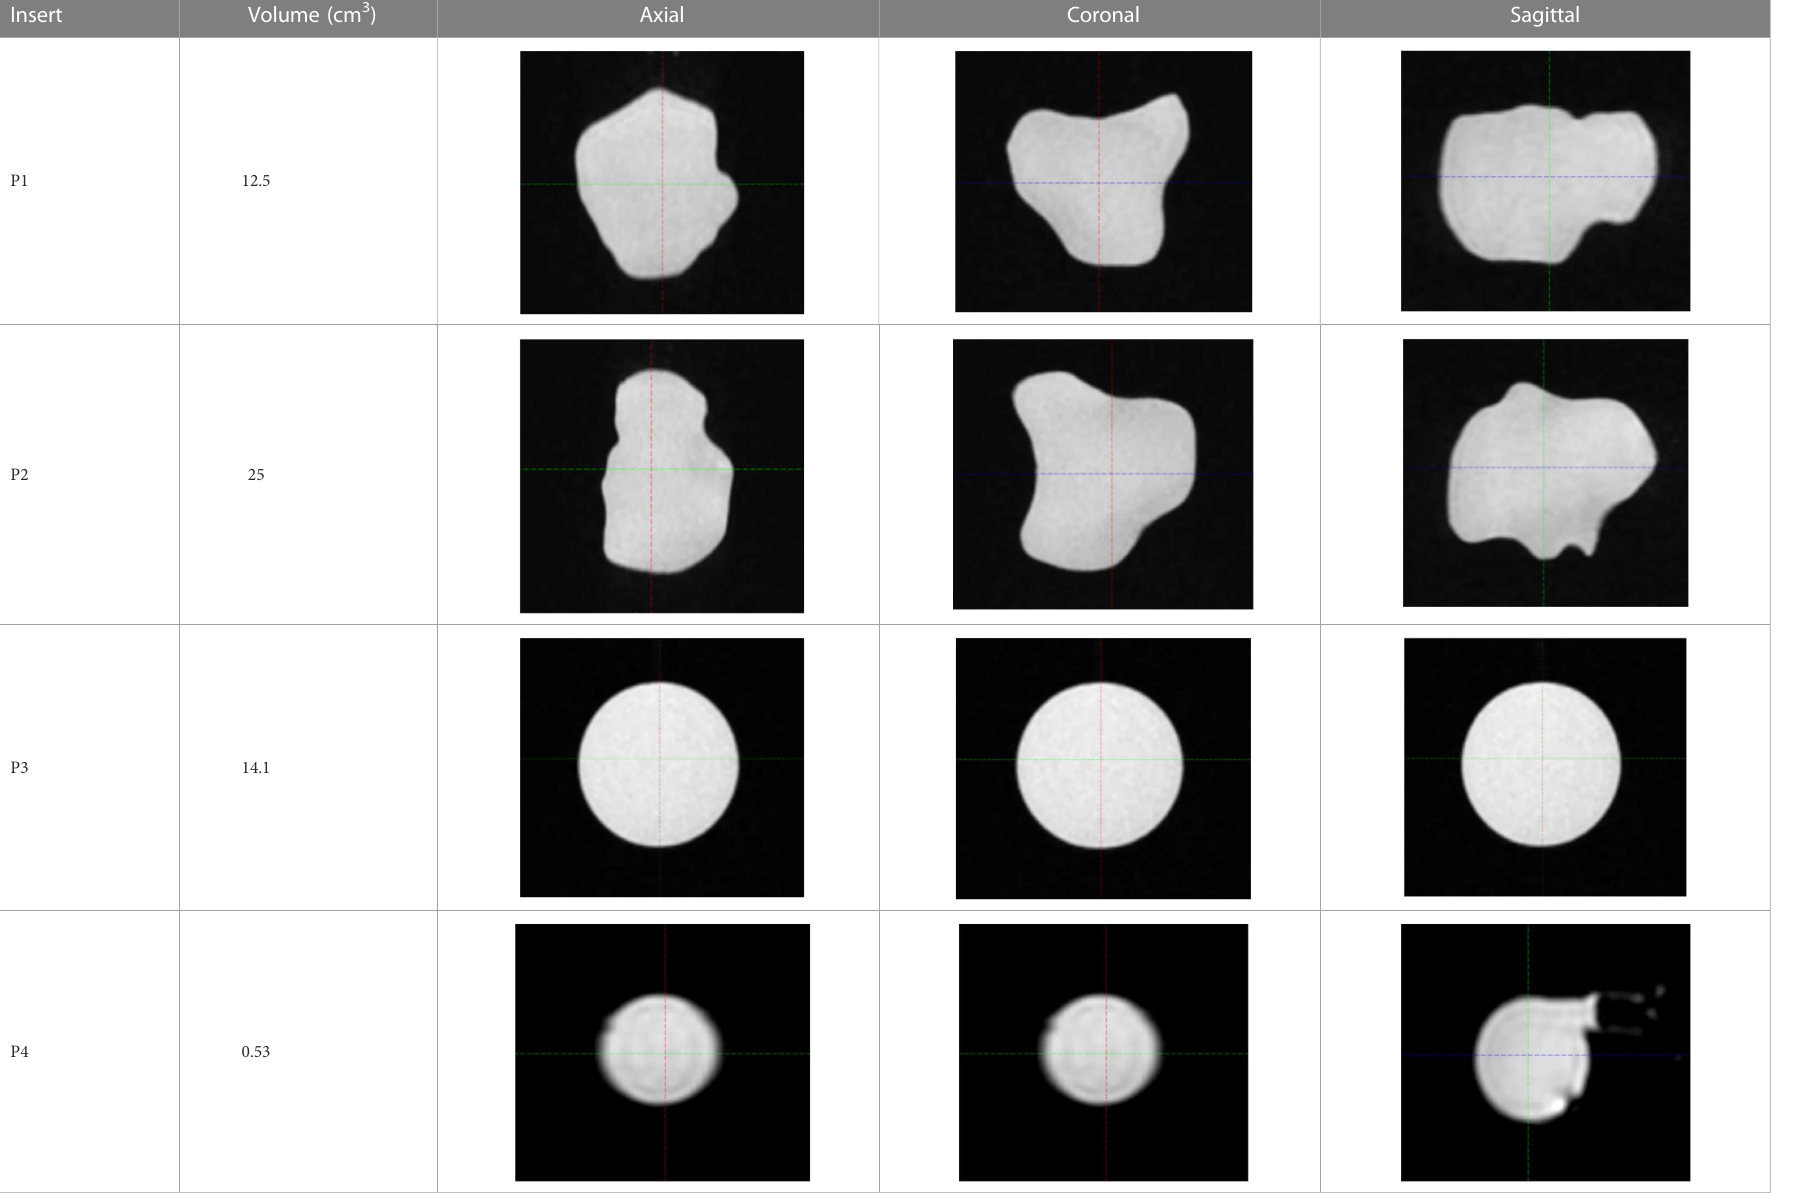
TABLE 1 Phantom inserts and simulated target shapes as shown in BRAVO MRI series.